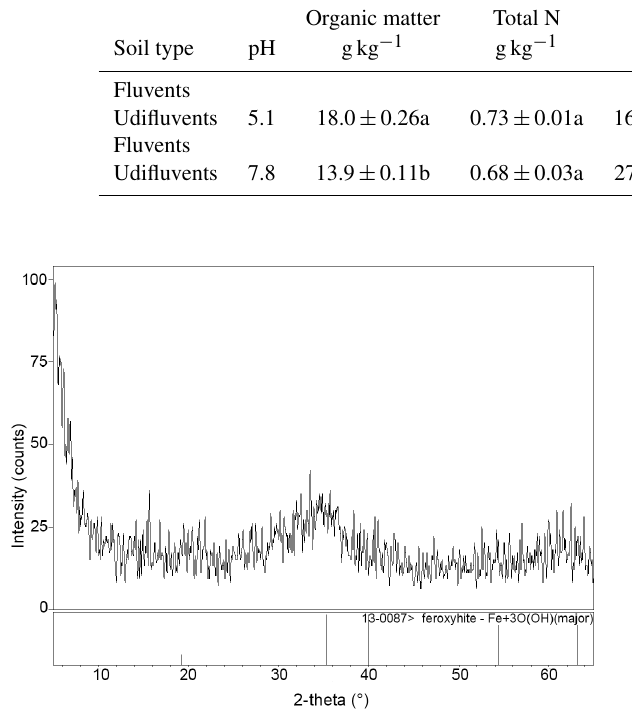
Figure 1. X-ray diffraction pattern of